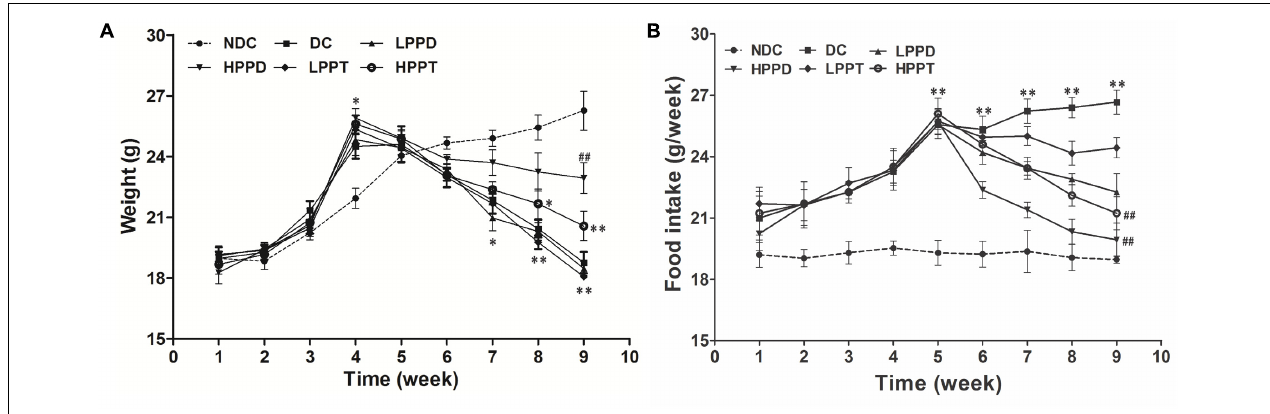
FIGURE 3 | Effects of PPD and PPT on (A) body weight and (B) food intake in high-fat diet and STZ-induced diabetic mice during the whole feeding period. ∗ p < 0.05, ∗∗ p < 0.01, ∗∗∗ p < 0.001 vs. NDC group; # p < 0.05, ## p < 0.01, ### p < 0.001 vs. DC group. Different groups were significantly different ( p < 0.05).